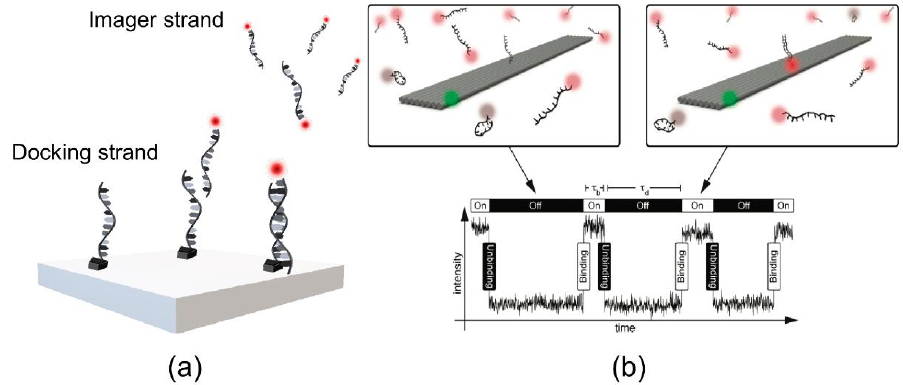
Figure 8. DNA-PAINT (point accumulation for imaging in nanoscale topography). ( a ) Imager strand labeled with fluorescence dye and the docking strand on the surface of a synthetic DNA origami. ( b ) The transient binding (hybridization) of the imager strand to the docking strand will switch the fluorescence “on” and “off.” The image was reproduced with permission from Jungmann et al., published by American Chemical Society, 2010 [17].